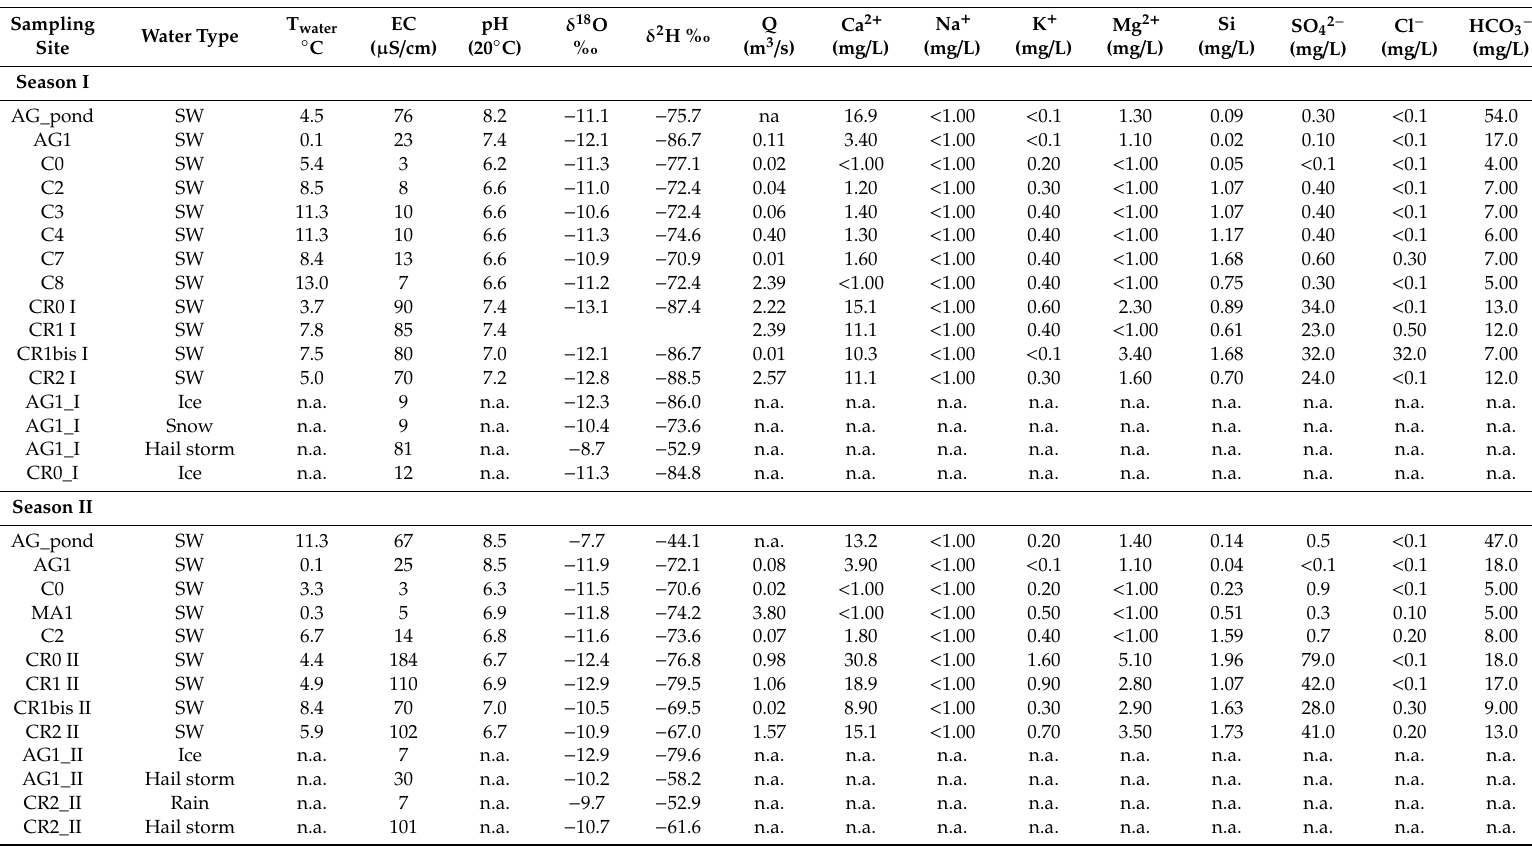
Table 2. Physico—chemical parametrs, geochemical data and discharge of waters collected in this study. SW stands for Stream Water. Sampling